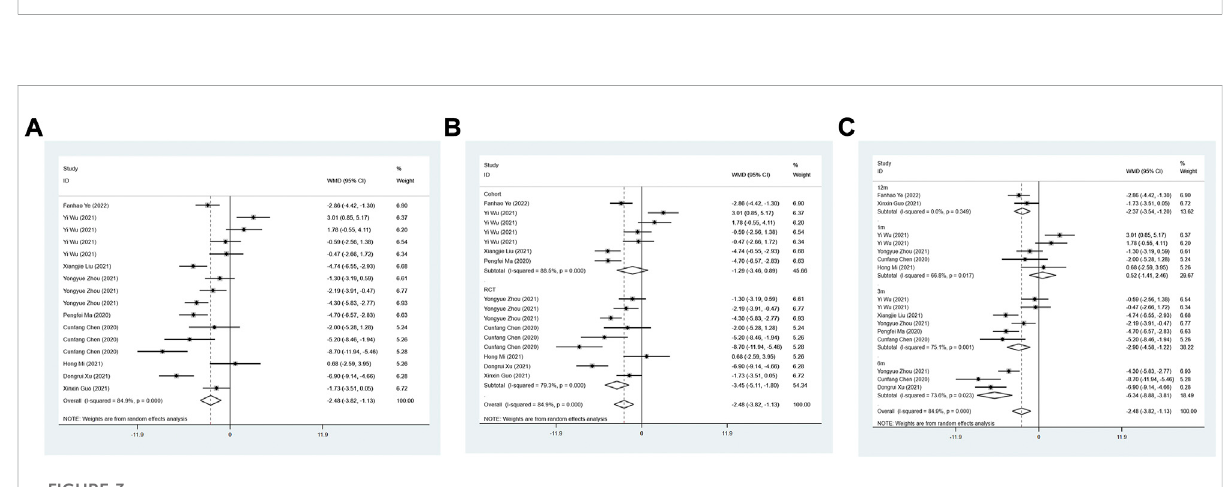
FIGURE 3 Forest plot of LVEDD between sacubitril-valsartan and ACEI or ARB; (A) overall; (B) subgroup analysis of study type; (C) duration of